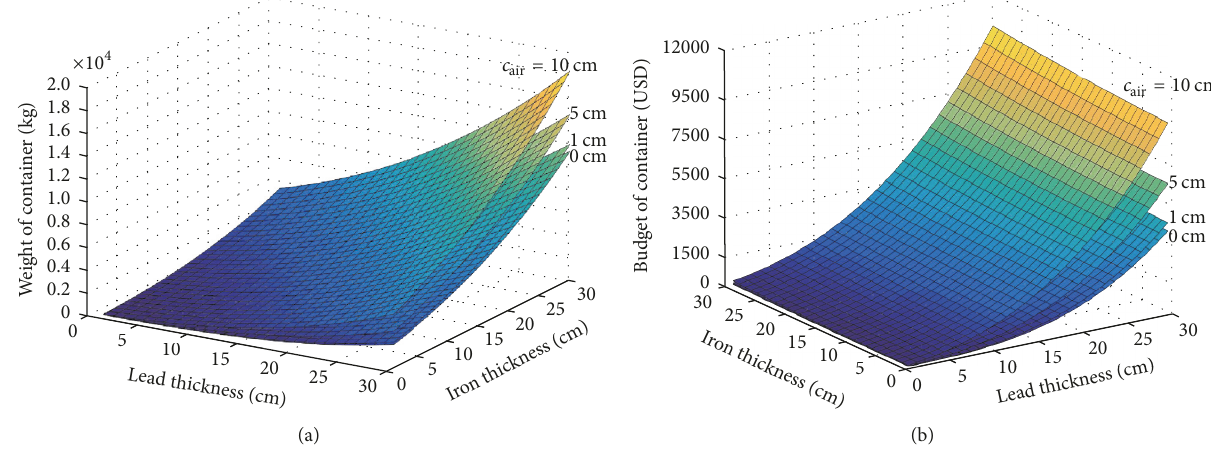
Figure 9: Variation of the space or void (𝑐 air ) of container on (a) container weight and (b) container cost.